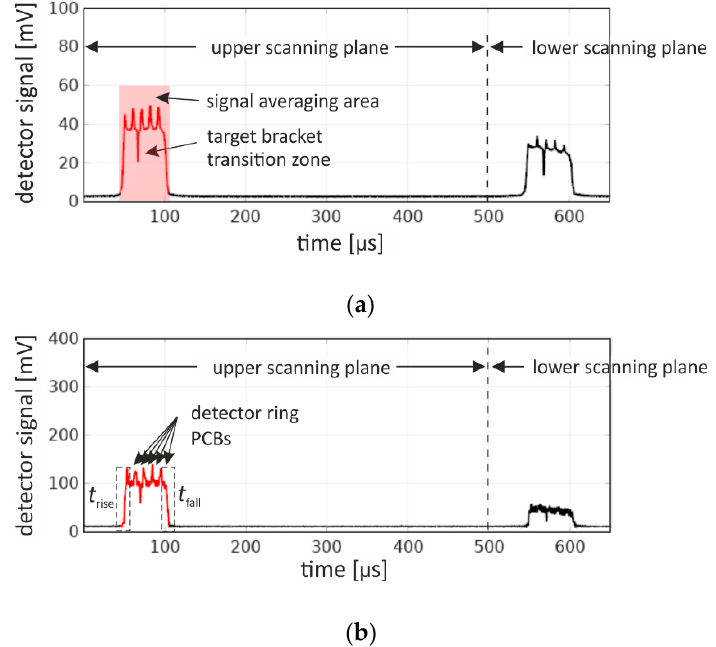
Figure 12. Detector output signals at X-ray exposure height z 1 = 49 mm and for an electron beam current of 8 mA for ( a ) a sandwich and ( b ) a monolithic bar detector. Signals are deflection-synchronized and averaged over 5 s measuring interval. The red marked signal section assigns the region for signal averaging for further investigations at different X-ray exposure heights and electron beam currents to suppress both X-ray statistics and X-ray flux fluctuations.